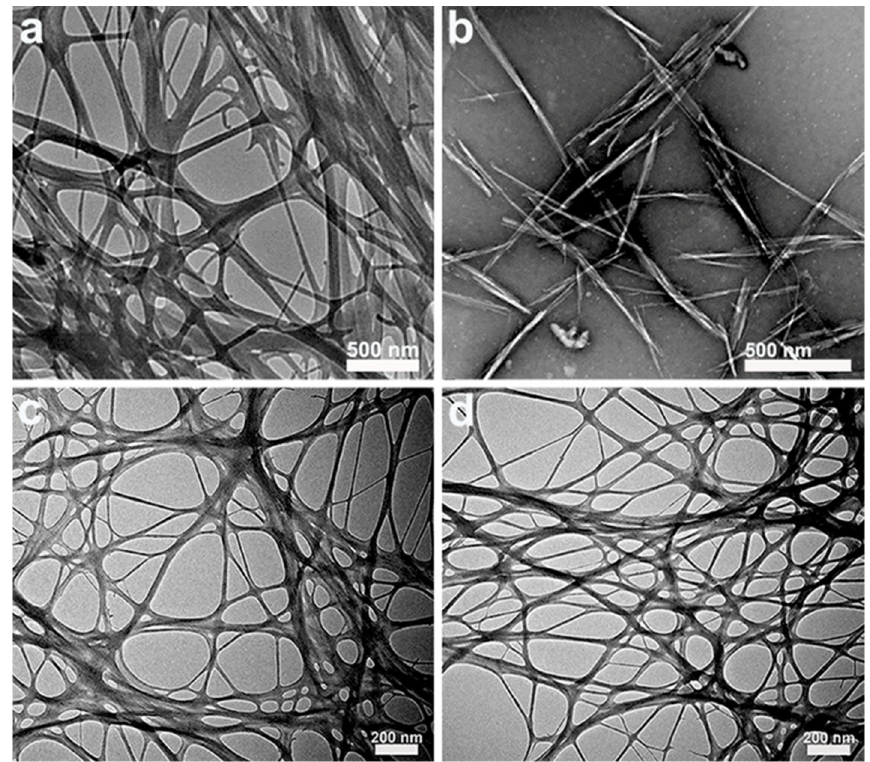
Figure 2. TEM images of ( a ) natural BC. Reprinted with permission from [16]. Copyright (2018), Elsevier. ( b ) BCNCs from BC by hydrochloric acid hydrolysis. Reprinted with permission from [17]. Copyright (2011), American Chemistry Society. ( c ) BCNFs from BC treated by high-pressure homogenization and ( d ) TOBC from BC treated by TEMPO-mediated oxidation. Reprinted with permission from [18]. Copyright (2019), Elsevier.